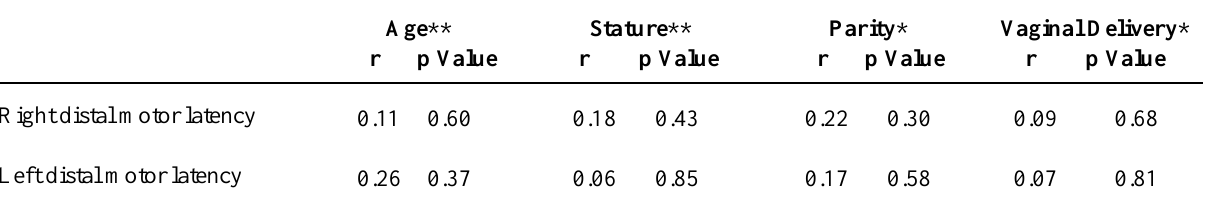
Table 2 – Correlation between the latency value on each side, the general characteristics, such as age (years), stature (cm), parity (number of deliveries) and the number of vaginal deliveries.